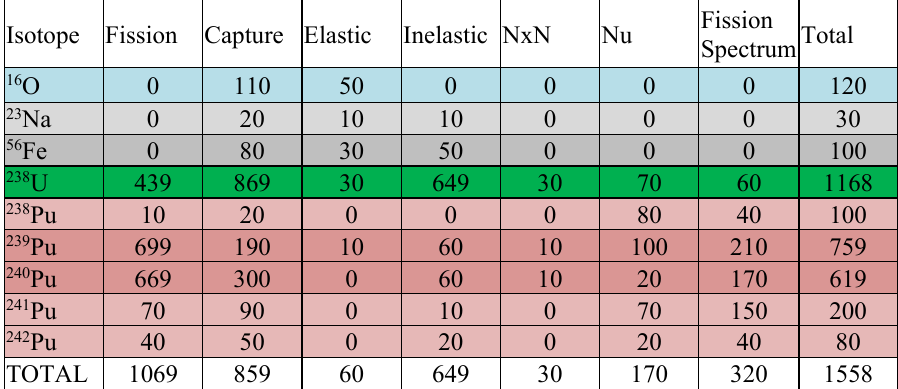
Table 1. Uncertainty breakdown (in pcm) on critical mass for the ASTRID core (using COMAC-V1 nuclear data